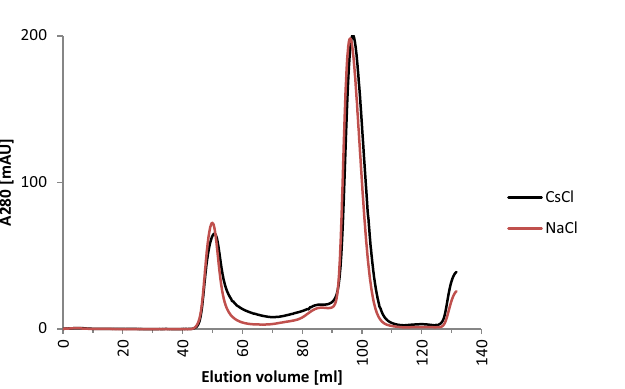
Figure 5. SEC elution profiles of the p62 PH domain in NaCl-buffer (red) and CsCl-buffer (black).